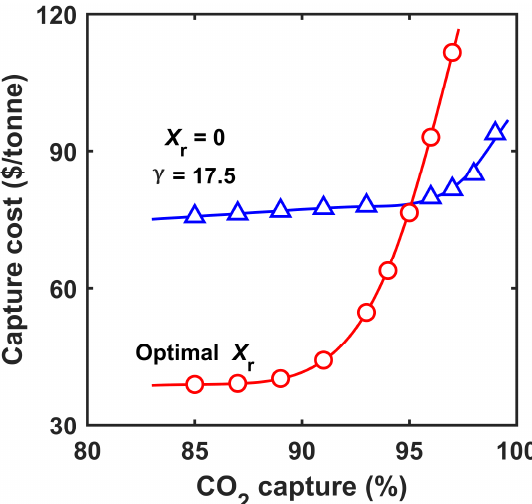
Figure 5. Capture costs of the primary system at different CO 2 capture degrees with (1) X r = 0 (triangle symbols) and γ = 17.5 and (2) the optimal X r values (circle symbols),